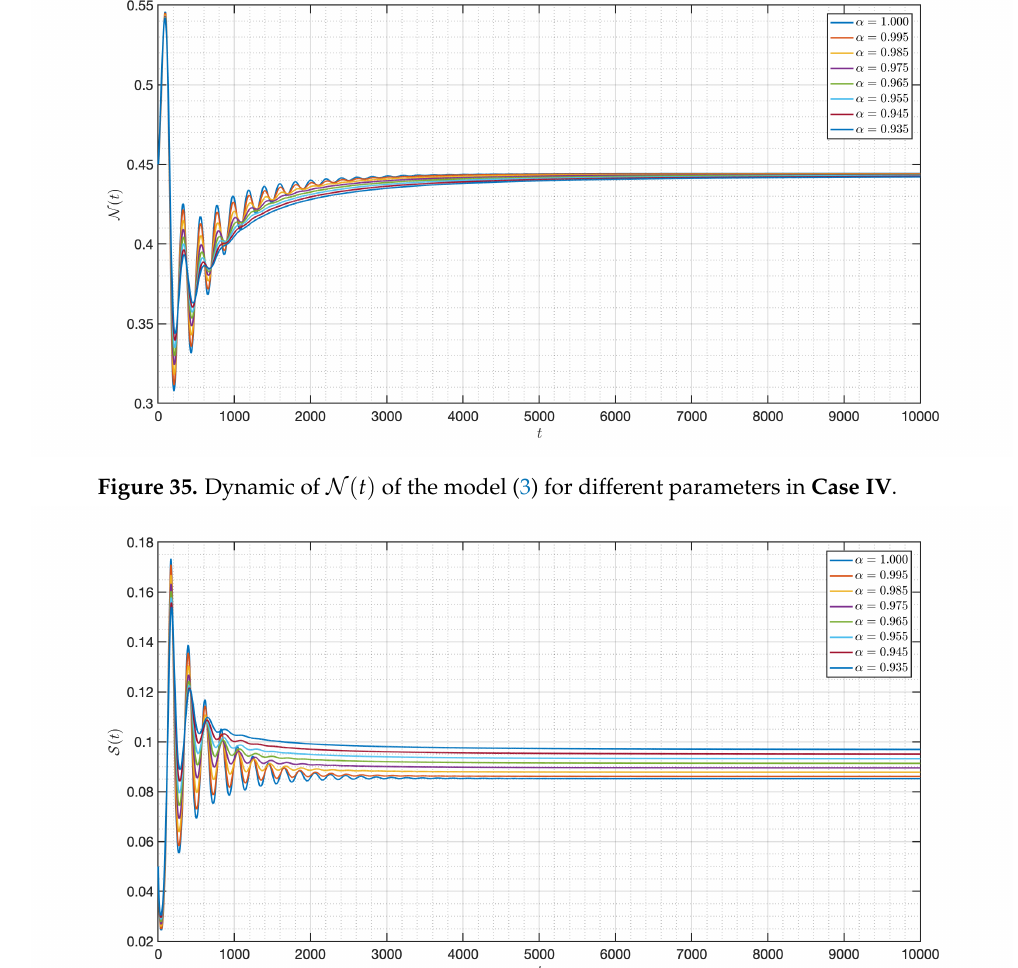
Figure 36. Dynamic of S ( t ) of the model (3) for different parameters in Case IV